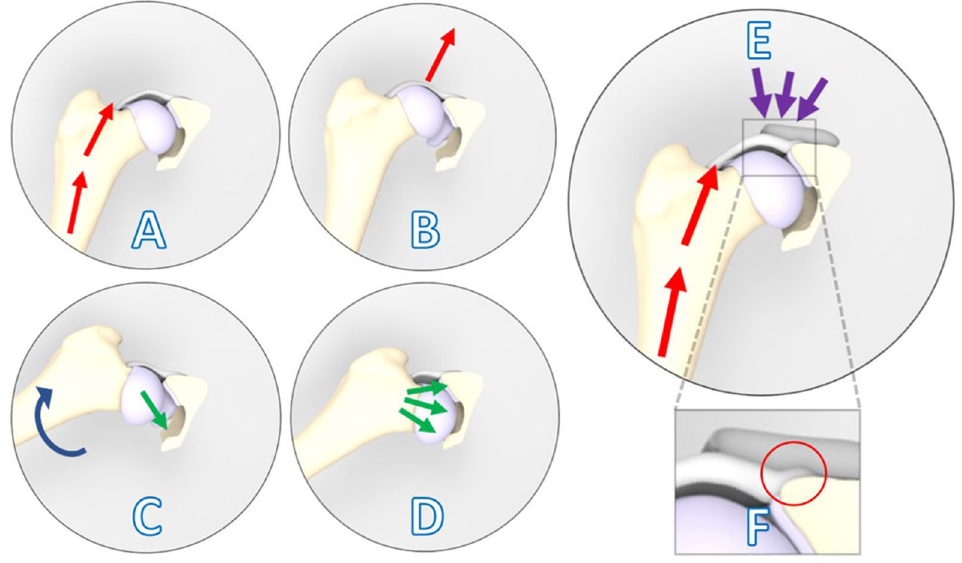
Figure 1. Laxity due to hip dysplasia is confirmed based on clinical examination (A-D) and is counteracted by implantation of the 3D-printed shelf implant (E). ( A ) The limb is in neutral flexion and in an adducted position, and force is applied toward the dorsum of the dog along the femoral axis (red arrows). ( B ) This force causes dorsal subluxation in a hip with joint laxity due to hip dysplasia. ( C ) During the Ortolani (reduction) test, the limb is slowly abducted (blue arrow) while force on the femur (red arrows) is maintained. ( D ) A positive Ortolani sign is evident when a click is heard or palpated as the subluxated femoral head reduces into the acetabulum (green arrows) 17 . ( E ) Introduction of the shelf implant ideally stabilizes the joint by reinforcing the hip capsule and labrum as a weight bearing and stabilizing surface (purple arrows). In close-up the internal 2 mm offset of the implant is visible that allows the capsule attachment to remain unaffected ( F ).